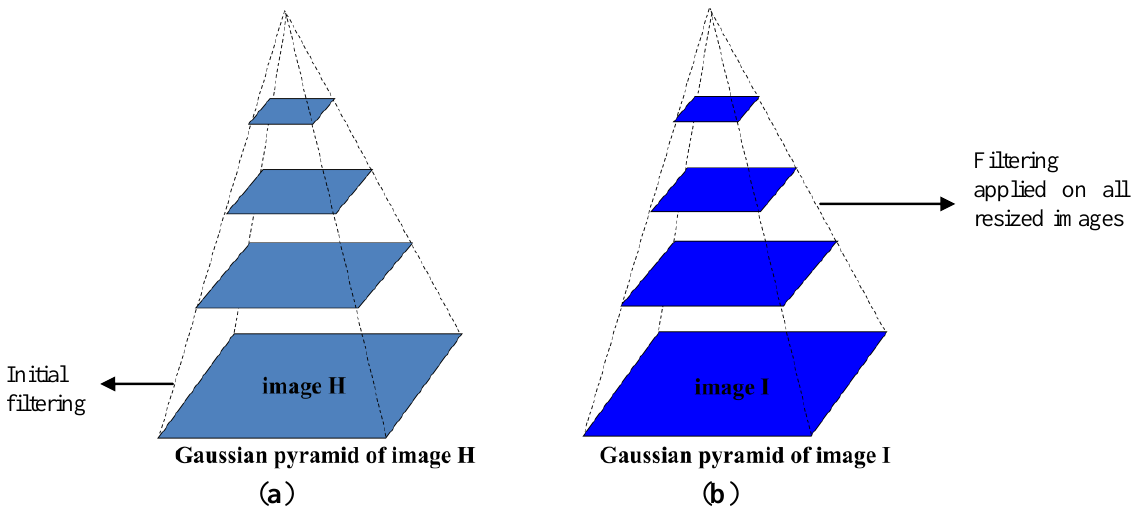
Figure 4. Coarse-to-fine optical flow estimation, ( a ) initial filtering and ( b ) filtering at all levels.